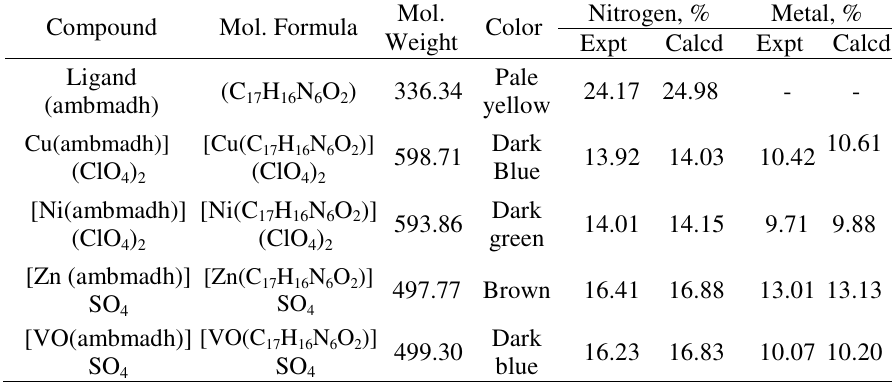
Table 1 . Analytical and physical data of the compound